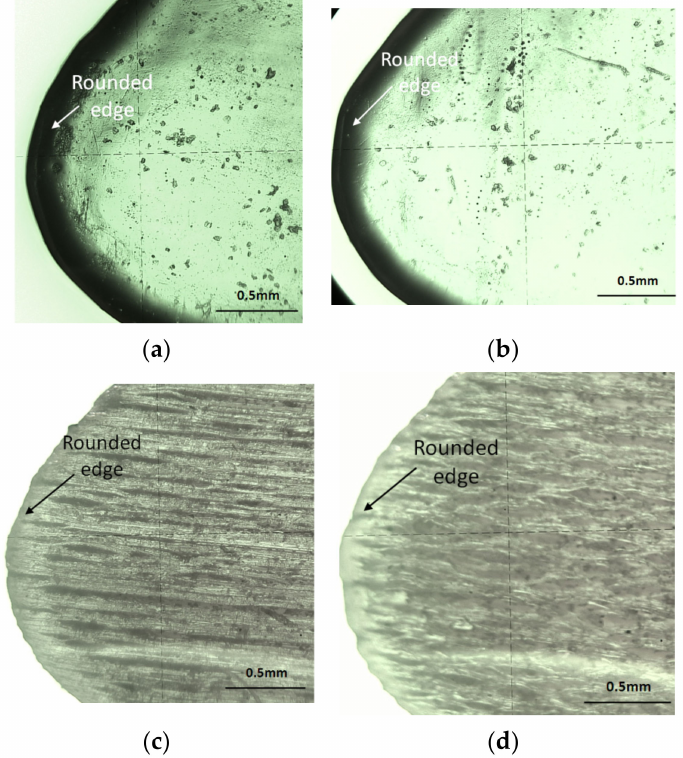
Figure 19. Lateral surface view of the airfoil on the leading-edge zone: ( a ) glossy XY; ( b ) glossy YX; ( c ) matte XY; ( d ) matte